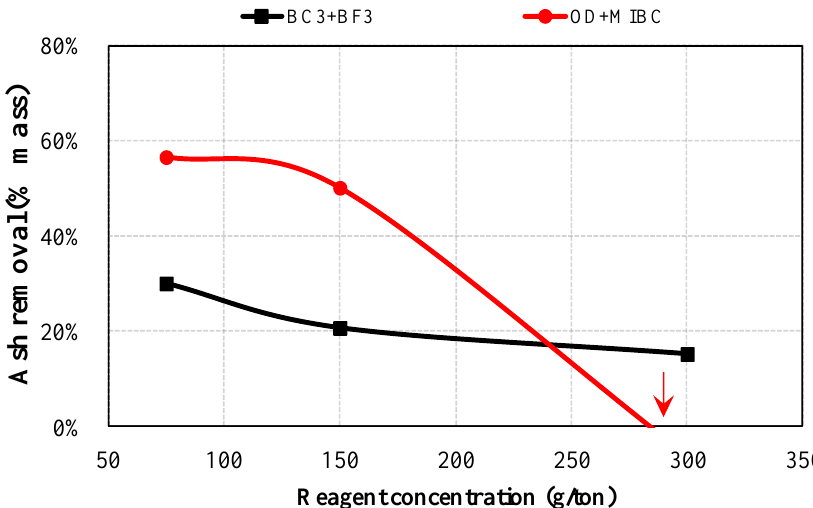
Figure 7. Ash removal in the preliminary flotation tests with the 20 m sample.